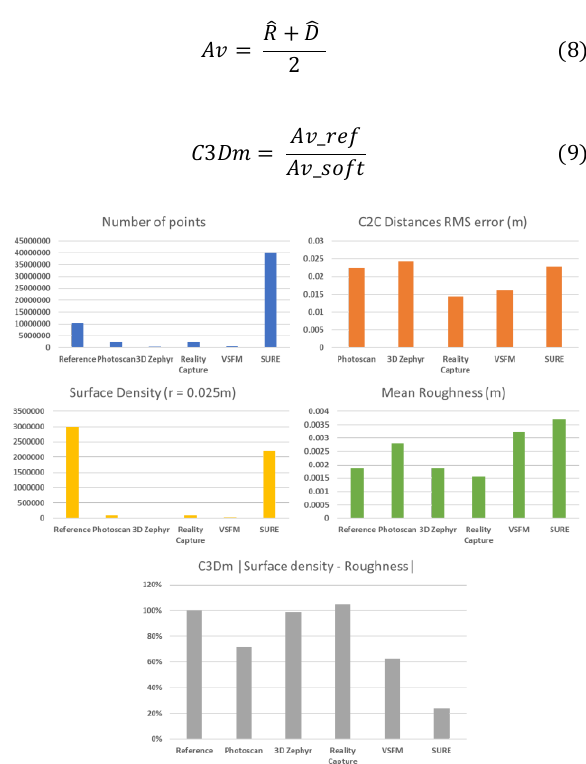
Figure 6: Visual representation of all the metrics that were